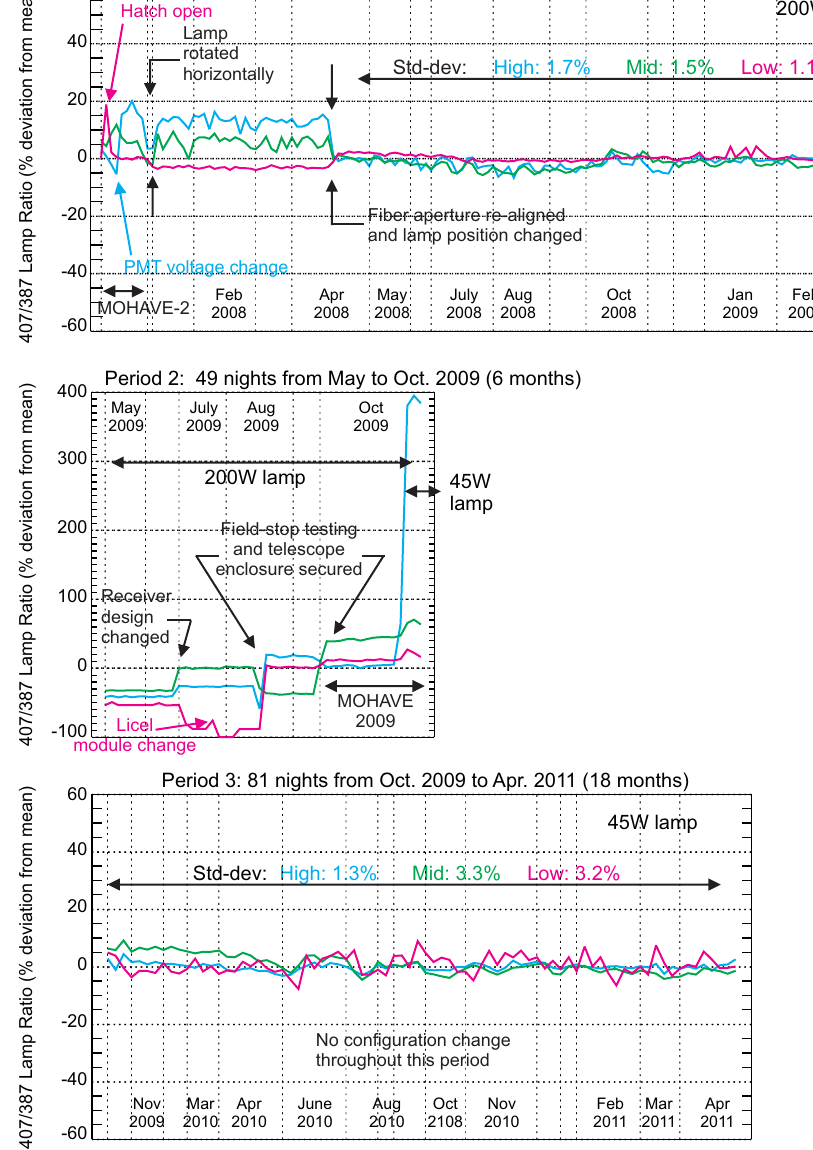
Fig. 17. Historical evolution of the 407nm to 387nm channel ratios (pink: low-intensity, green: mid-intensity, and blue: high-intensity) between October 2007 and present. All instrumentation changes are denoted by arrows and comments, including the change of lamp (from 200W to 45W) in October